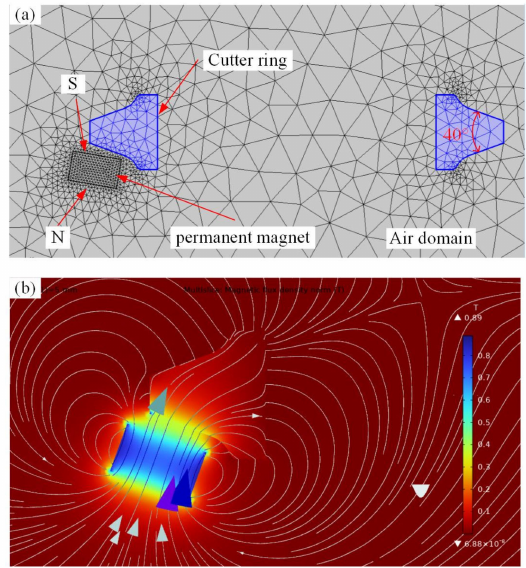
Figure 3. Finite element simulation of magnetic force: ( a ) Finite element model; ( b ) Simulation results of the magnetic